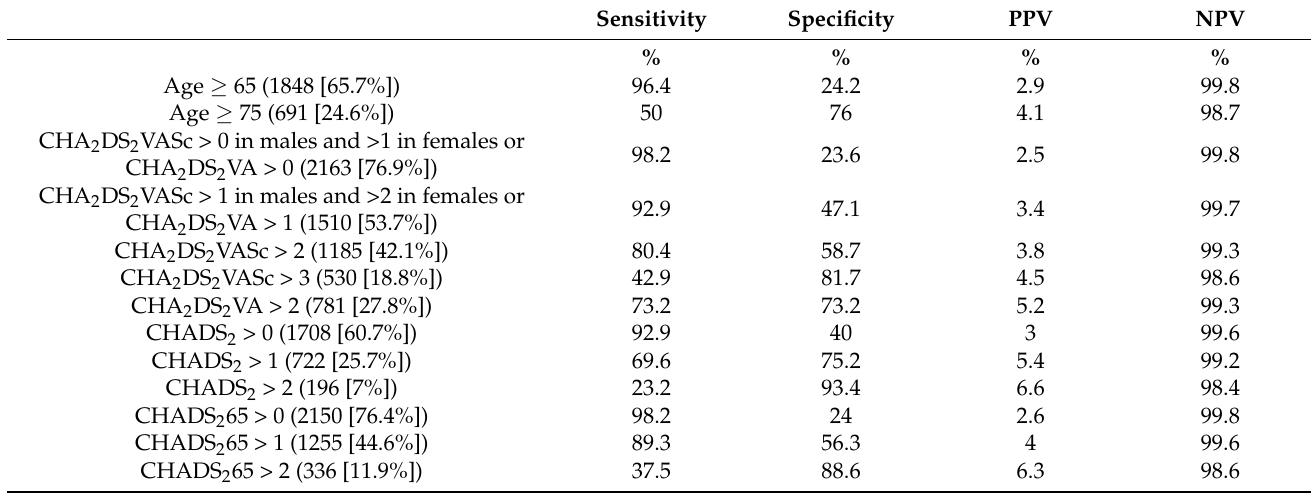
Table 2. Sensitivity, specificity, positive predictive value and negative predictive value of different risk stratifiers’ cut-off values with regard to identification of subjects with screen-detected AF, as confirmed by 12-lead